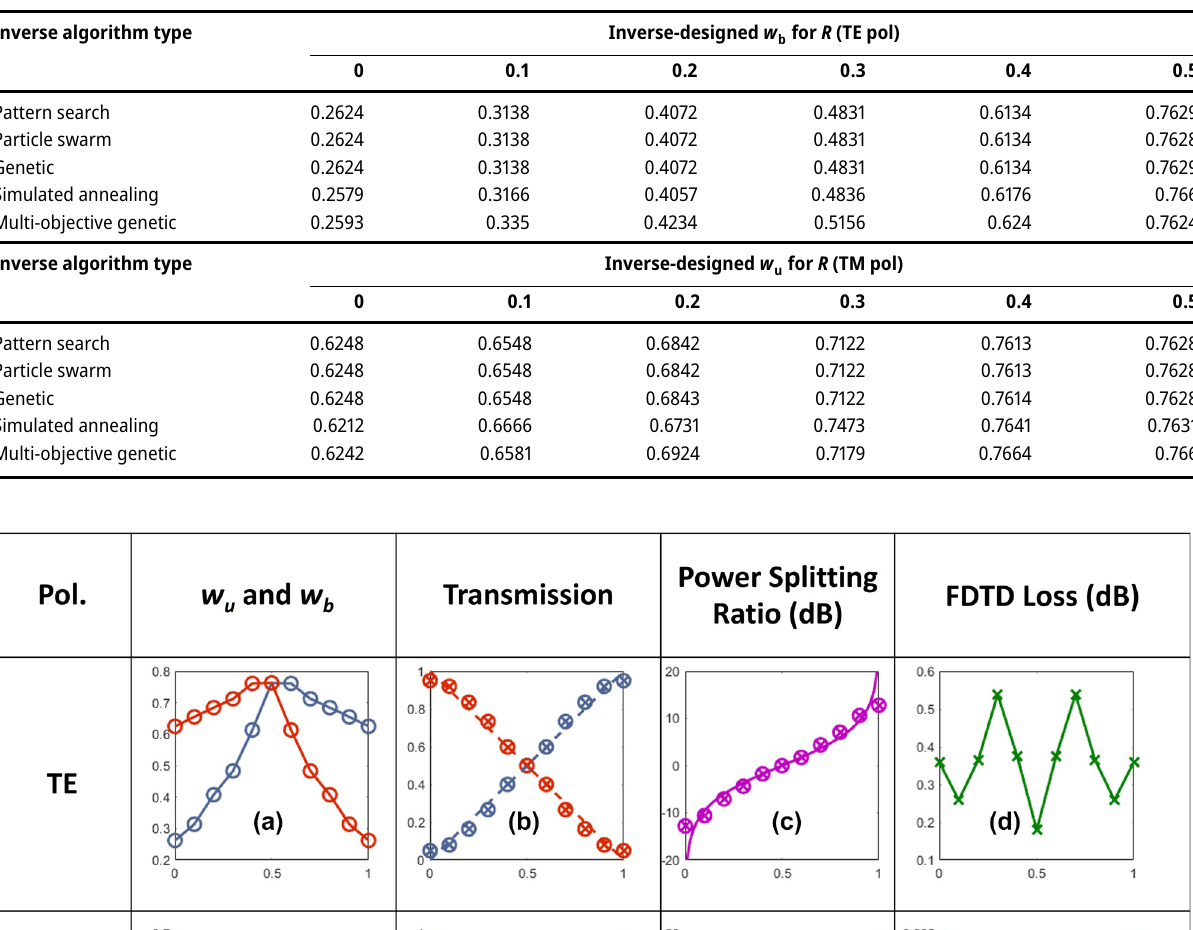
and w as in (a). (c) The power splitting ratio for the devices u b and w as in (a). In (b)–(d) lines: ideal values, circles: deep learning predictions, u b